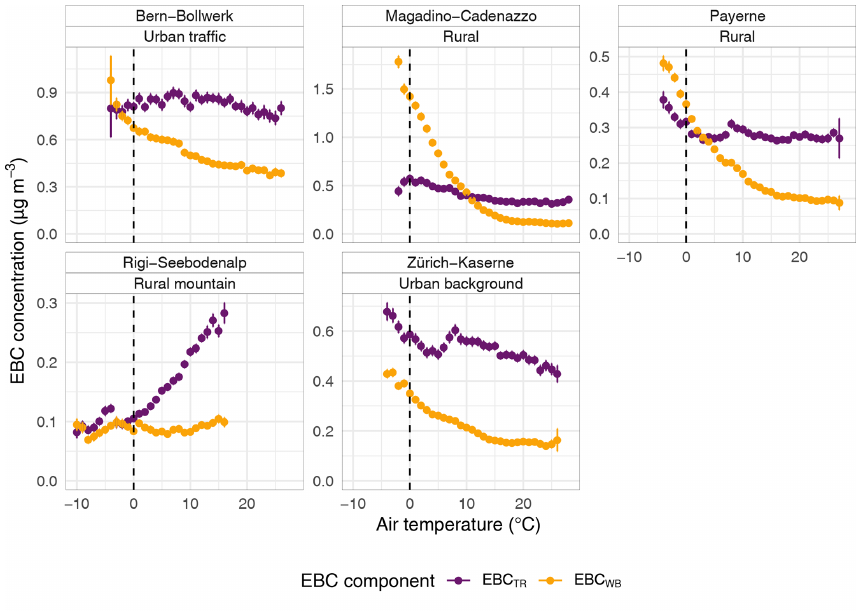
Figure 8. EBC TR and EBC WB dependence on air temperature for five equivalent black carbon (EBC) monitoring sites in Switzerland. CI: confidence